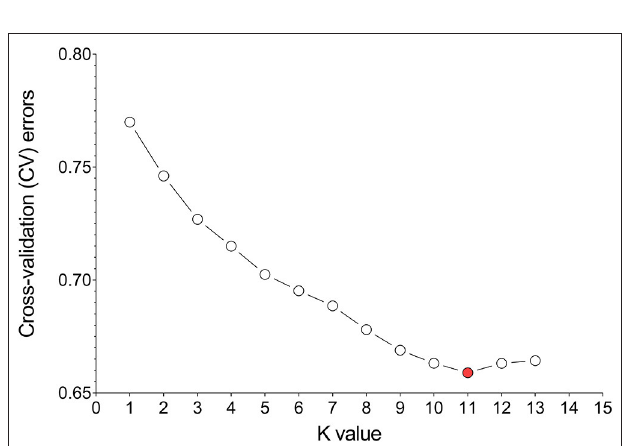
FIGURE 7 | Estimation of cross-validation (CV) errors for K values ranging from 2 to 13. The CV errors declined rapidly from K = 2 ∼ 11 and reached the lowest value at K =